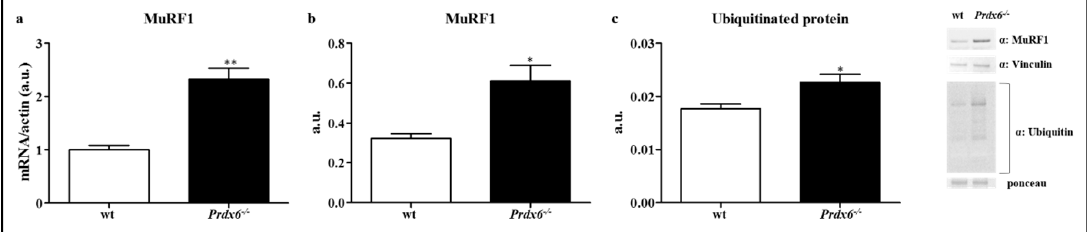
Figure 6. Prdx6 deletion activates MuRF1-Ubiquitin pathway. Gene ( a ) and protein ( b ) levels of MuRF1 were evaluated in gastrocnemius of wt (white bar) and Prdx6 - / - (black bar) mice. ( c ) Ubiquitination of muscle proteins was analyzed in Prdx6 - / - mice. Results are expressed as mean ± SE. * p < 0.05, ** p < 0.005 using Student t test. Graphs illustrate one of three separate studies, all yielding similar results ( n = 5 mice per group). a.u. = arbitrary